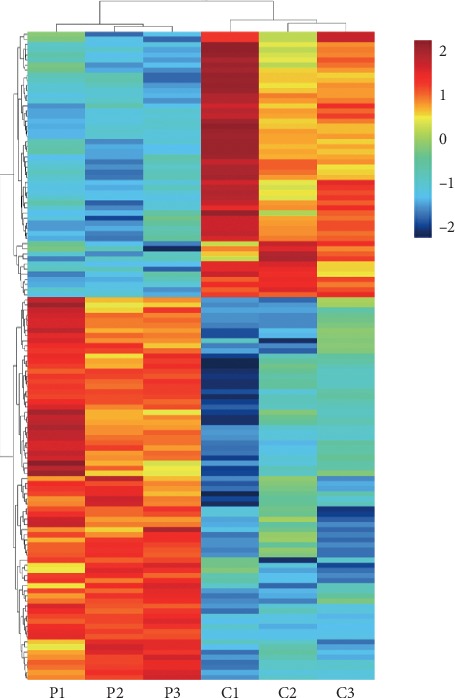
Hierarchical clustering analysis for specific lncRNAs (75 lncRNAs were upregulated and 52 lncRNAs were downregulated) in plasma exosomes from coronary artery disease (CAD) patients (criteria: fold change ≥2 or fold change ≤0.5; P < 0.05). P, Patient; C, Control.